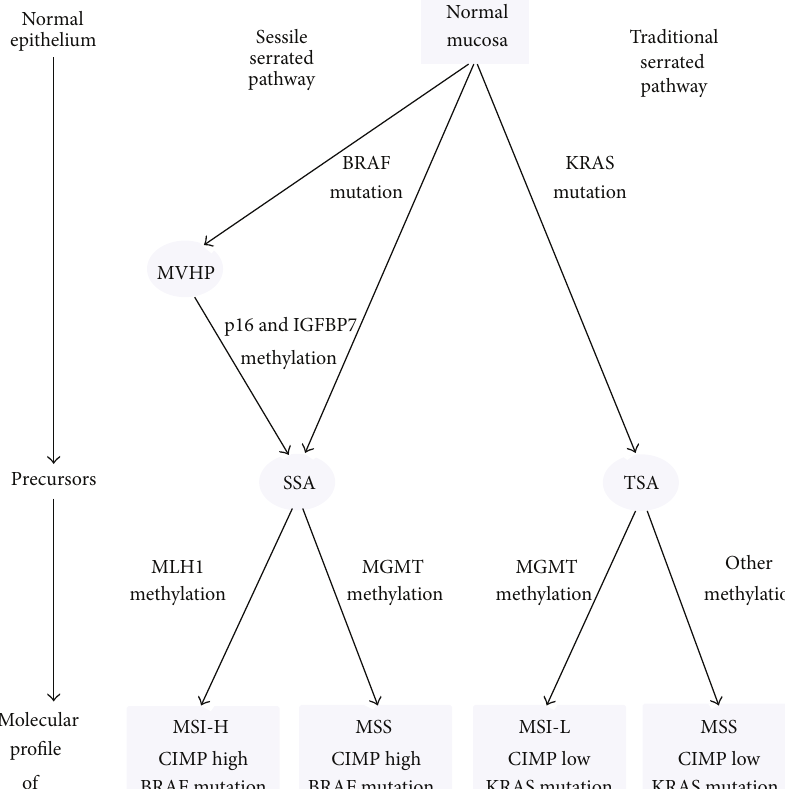
Figure 1: Sessile serrated and traditional serrated pathways. The first pathway consists of molecular profile cancers which are CpG island methylator phenotype-high (CIMP-high) and BRAF mutation positive with microsatellite instability being high (MSI-H) or stability (MMS). The precursor of these cancers may be MVHP and SSA. The second pathway consists of CpG island methylator phenotype-low (CIMP-low), KRAS mutations positive with microsatellite stability or instability being low (MSI-L). The precursor lesion in this second pathway may be TSA. MVHP: microvesicular hyperplastic polyp; SSA: sessile serrated adenoma; TSA: traditional serrated